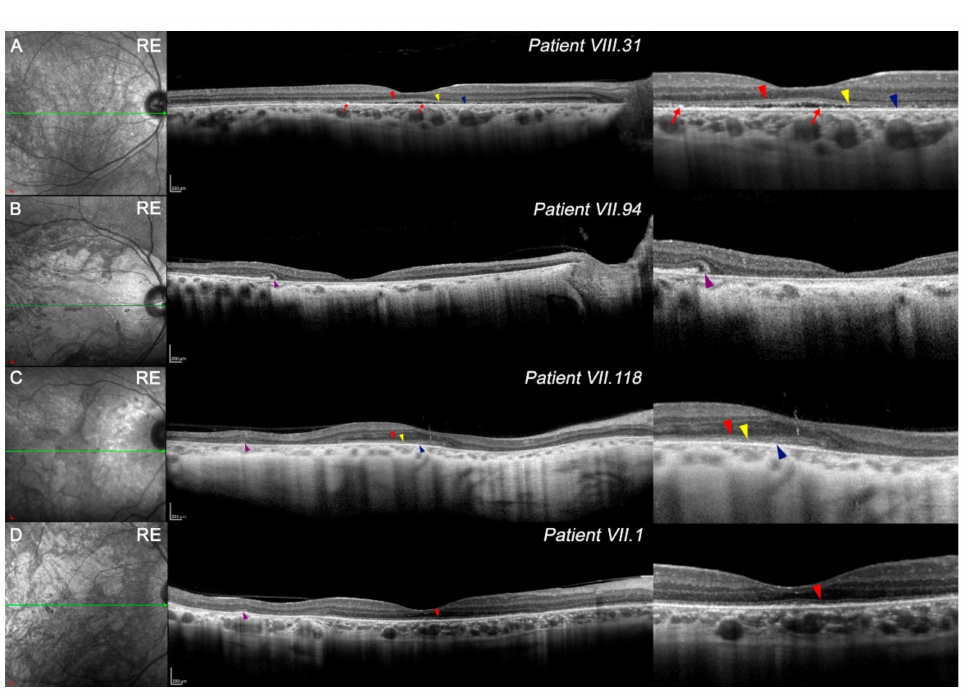
Figure 2. IR images (left) and OCT line scan at the foveola (right) in study patients. Right-side insets of all images show different signs in high magnification. ( A ) The retinal structure of patient VIII.31 is maintained, although a general thinning exists along the fovea, mainly on the temporal side. First (red arrowhead), second (yellow arrowhead), and fourth (blue arrowhead) outer retinal bands are preserved at some areas and some hyperreflective loci, which may be related to the third band (red arrows). ( B ) Patient VII.94 presented almost complete degeneration along the retina, specifically at the fovea, and outer tubulations can be observed (purple arrowhead). Part of the outer nuclear layer remained on the most temporal side. ( C ) Patient VII.118 showed a nasal and temporal reduction in thickness. Some outer retinal bands were observed at the fovea (red, yellow, and blue arrowheads), and outer tubulations related to this degenerative process can be also seen on the temporal side (purple arrowheads). ( D ) Patient VII.1 exhibited a marked reduction in the outer nuclear layer and only the first outer band is shown at the fovea (red arrowhead). Various outer tubulations were presented (purple arrowheads). Scale A–D: 200x 200 um. Images of contralateral eye presented a similar degeneration pattern, though are not shown. Red arrowhead, first outer retinal band; yellow arrowhead, second band; blue arrowhead, fourth band; red arrow, hyperreflective loci from band 3; purple arrowheads, outer